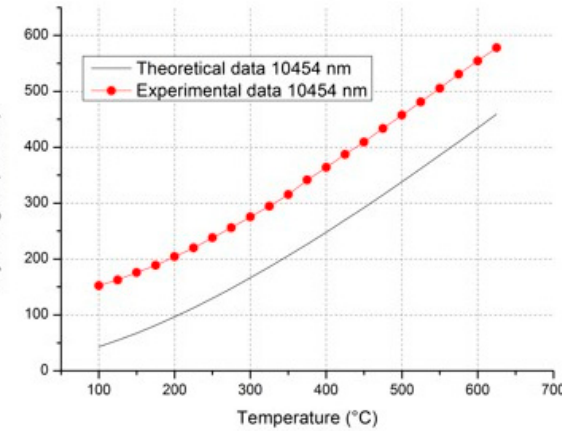
Figure 1. ( Left )—the experimental object signal (OS); OS1 = BP-10400-737, OS2 = BP-10500-775, respectively, with the cen- ter at 10.454 μ m and 10.464 μ m; trends versus temperature. ( Right )—the experimental SR = OS2/OS1 curve [6].